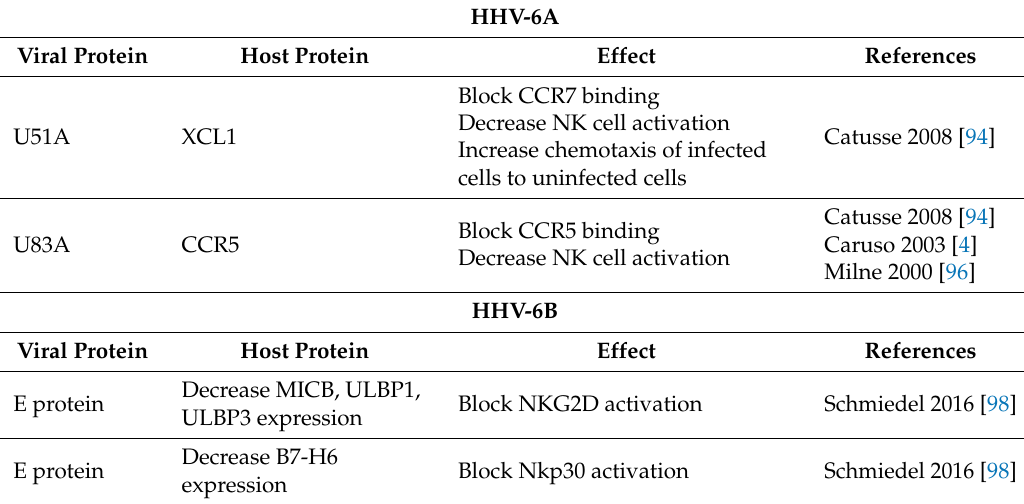
Table 3. HHV-6A and HHV-6B proteins involved in NK cell activation